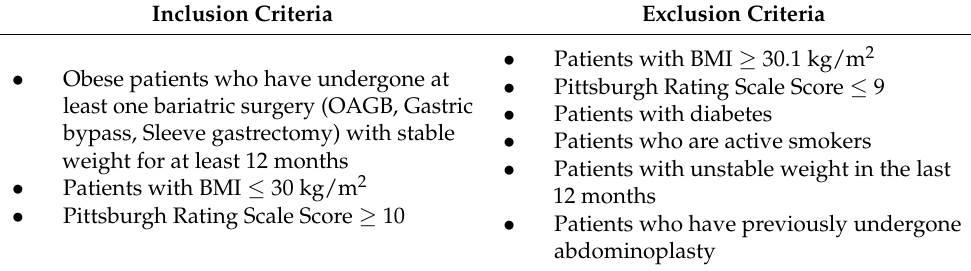
Table 1. Inclusion and Exclusion Criteria.